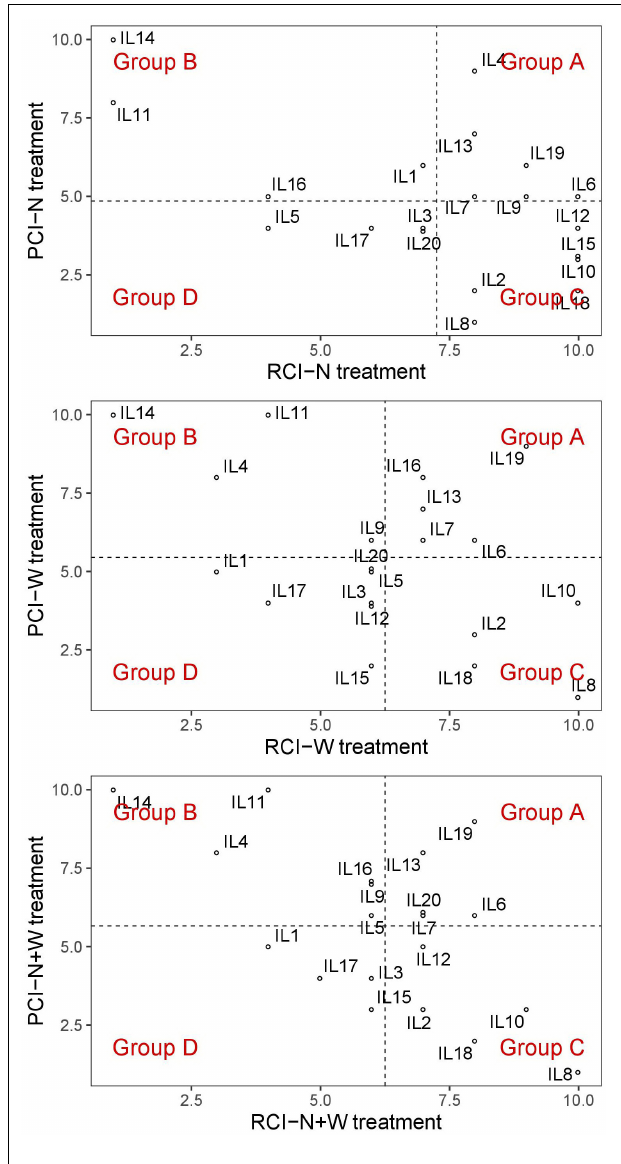
FIGURE 3 | Distribution diagram of twenty maize inbred lines (ILs) into four different response group (from A to D) according to their variation in resilience capacity index (RCI) and productive capacity index (PCI) calculated for nitrogen stress (N), water stress (W), and combination of nitrogen and water stress (N + W)